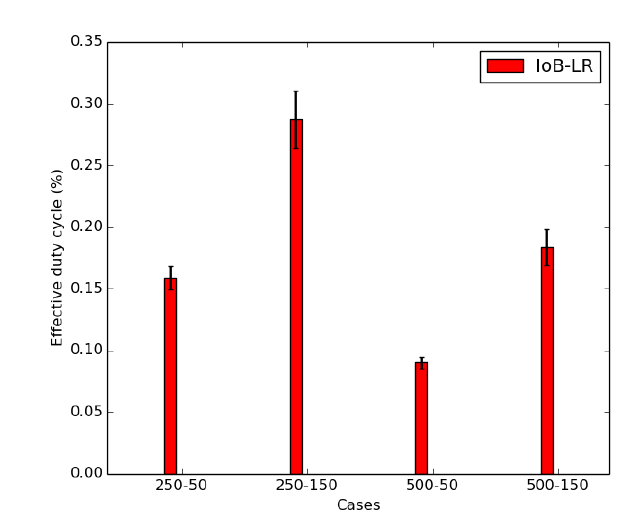
Figure 22. Average throughput.